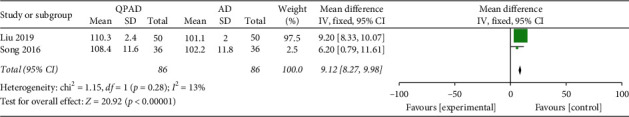
Forest plot of the trials showed life quality in QPAD vs. AD. Abbreviations: AD: antihypertensive drugs; QPAD: Qiju Dihuang decoction plus antihypertensive drugs.